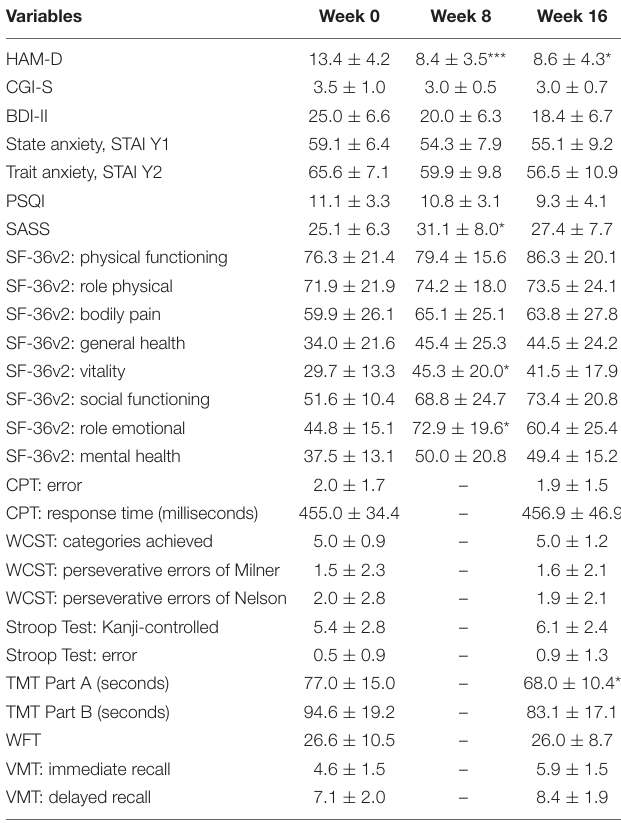
TABLE 1 | Outcome measure before, during, and after the exercise